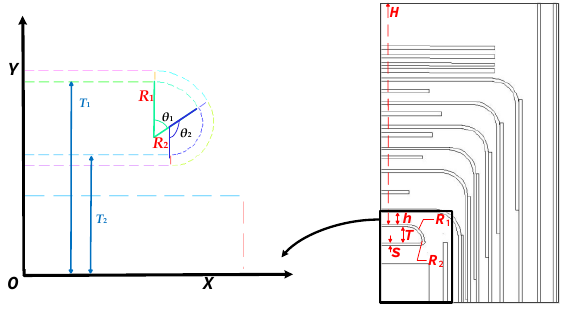
Figure 4. Structure and parameters of the electrostatic ring.